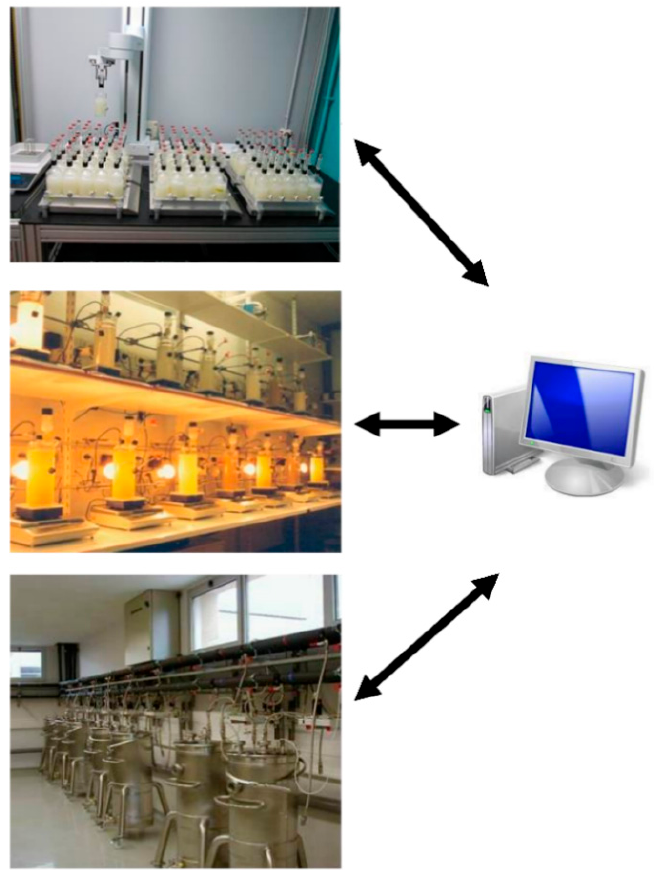
Figure 1. Online monitoring of CO 2 production rate at laboratory and pilot scale. Fermentation robot (360 × 20 mL or 90 × 300 mL), laboratory setup (16 × 1 L fermenters), and pilot scale (16 × 100 L tanks).